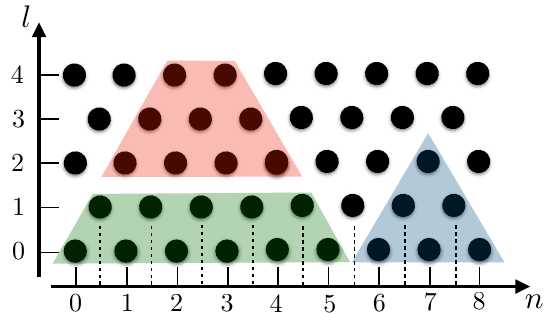
Figure 2: Each point ( n , l ) in the information lattice correspond to a line segment = [ n − l / 2, n + l / 2 ] . The value at a point is the information in the corresponding l n C line segment that cannot be found on any smaller scale. Every triangle for which ( n , l ) is the top consists of points that correspond to line segment subsets of summing all values in a triangle with base at l = 0 adds up to the total information in the line segment corresponding to the top of the triangle. As an example, summing the values in the blue triangle gives the total information in zero in some region, such as the red region in the top left, the density matrices in that region can be reconstructed from smaller density matrices corresponding to the green region in the bottom